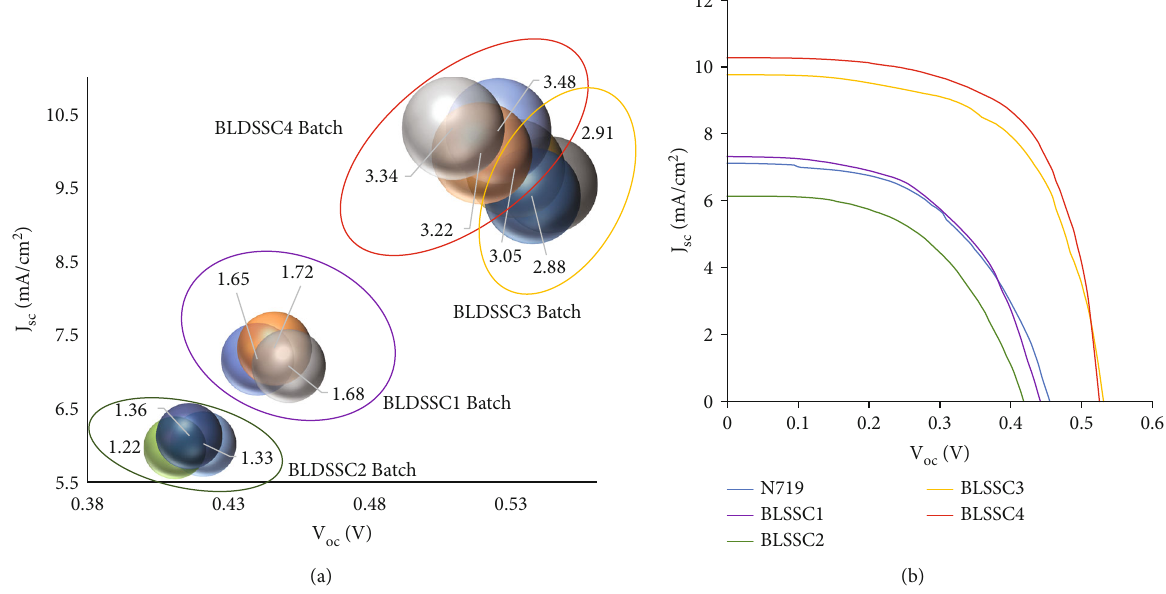
V sc and oc of the BLDSSC batches (the diameter of bubbles showed the e